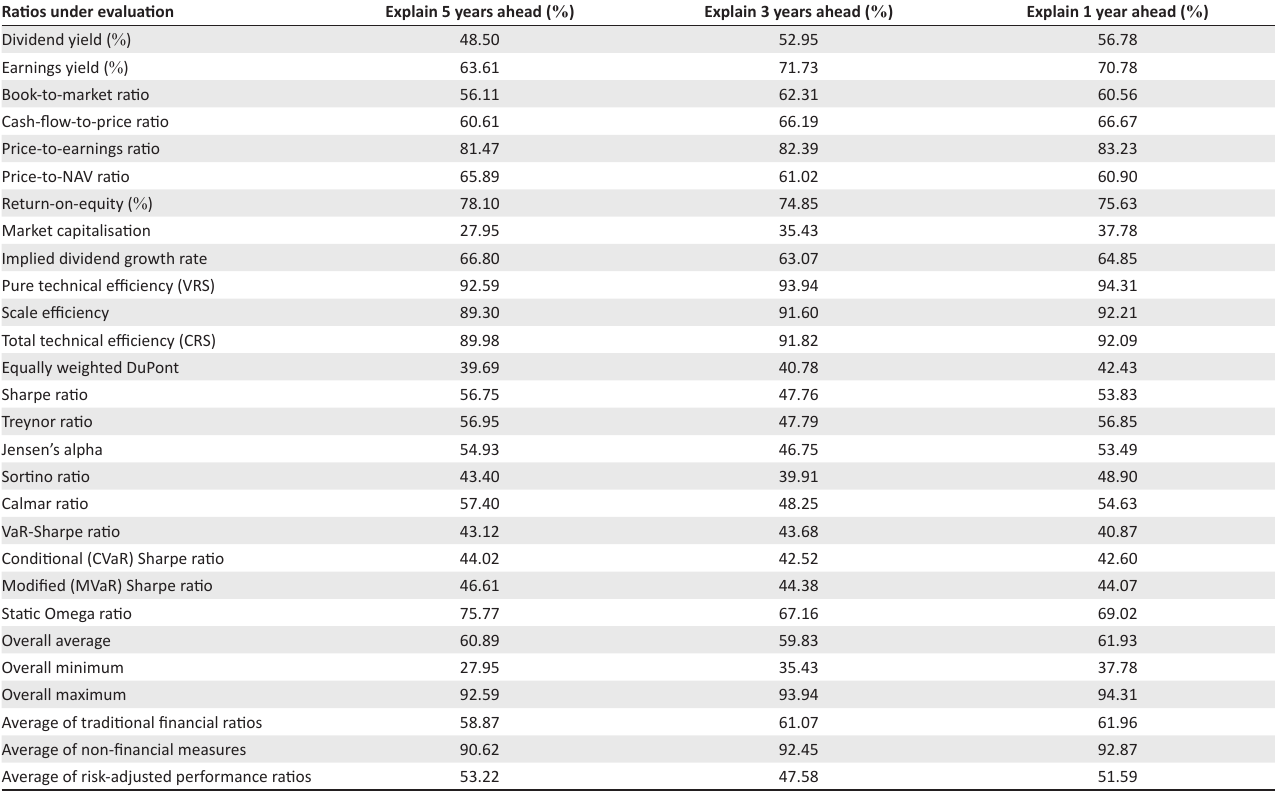
TABLE 1-A1: Average ability to explain future returns (across all